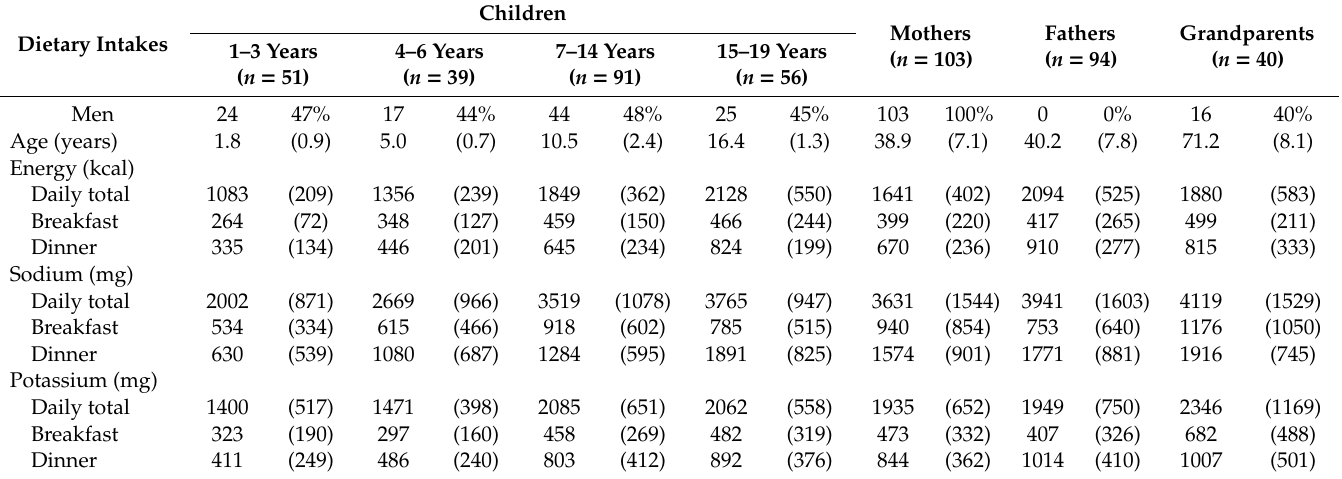
Table 1. Dietary intakes of children, mothers, fathers, and grandparents.